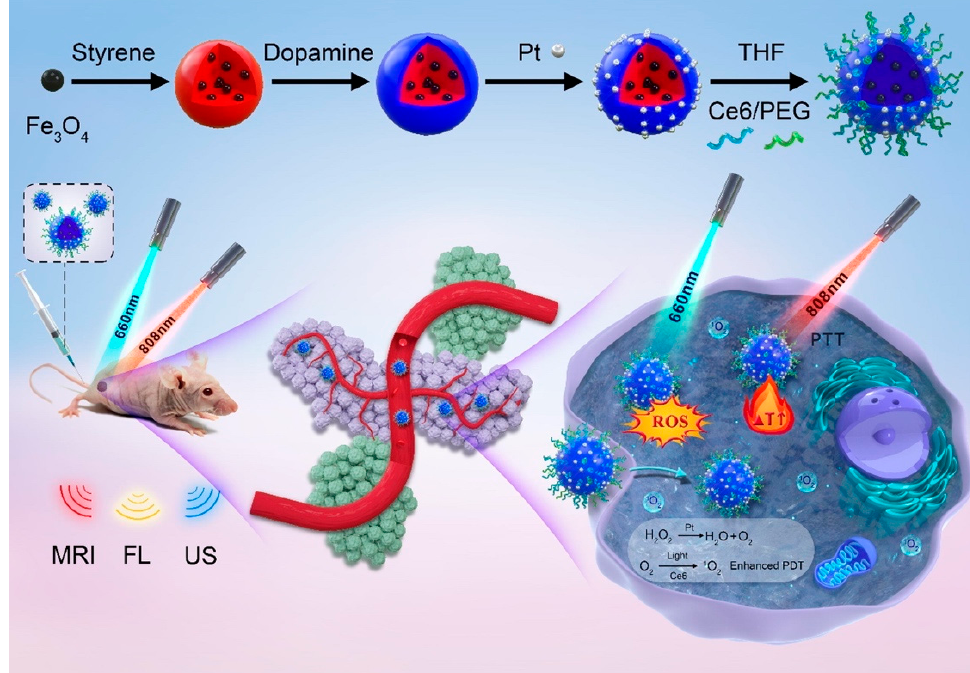
Figure 6. Schematic illustration of the preparation of yolk-shell Fe 3 O 4 @PDA@Pt-PEG-Ce6 and the use of the new nanoplatform for imaging and tumor phototherapy. Reprinted with permission from Ref. [107]. Copyright 2022, Elsevier Inc.